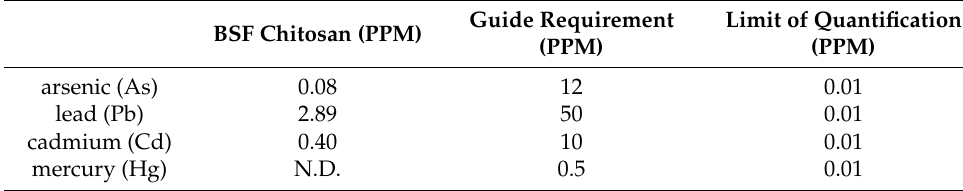
Table 2. The metal content of BSF chitosan.